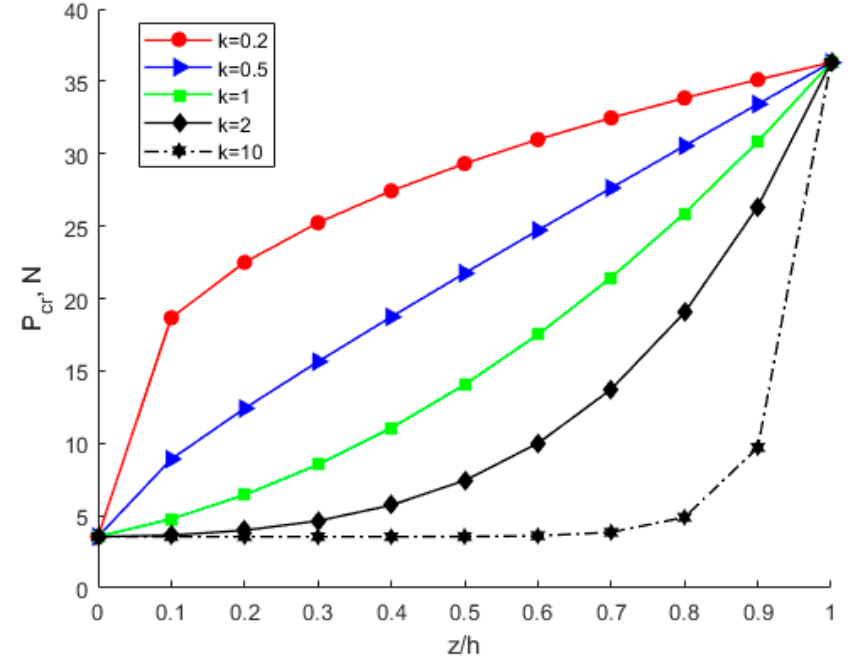
Figure 18. Influence of power-law distribution of scale effect on the critical buckling load.